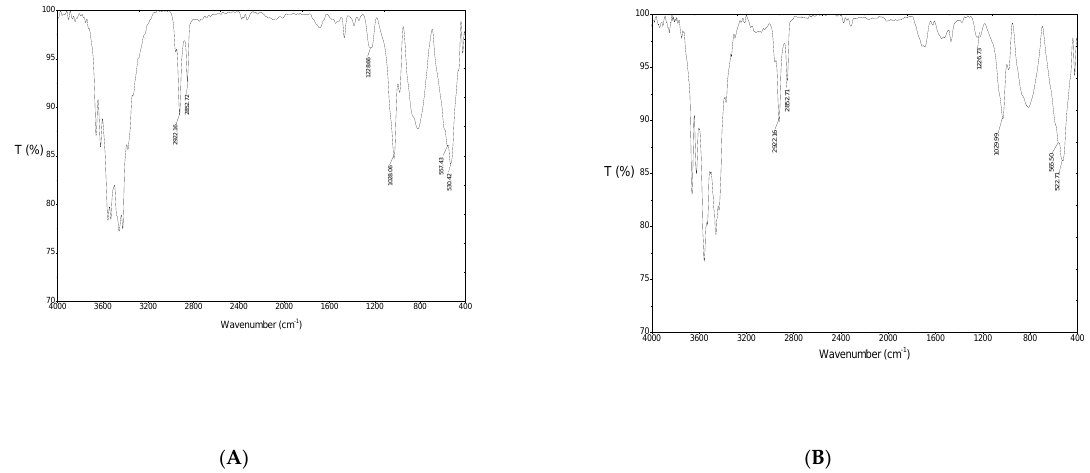
Figure 12. The FT-IR spectra of SMNAH ( A ) and SMNAH after lindane adsorption ( B